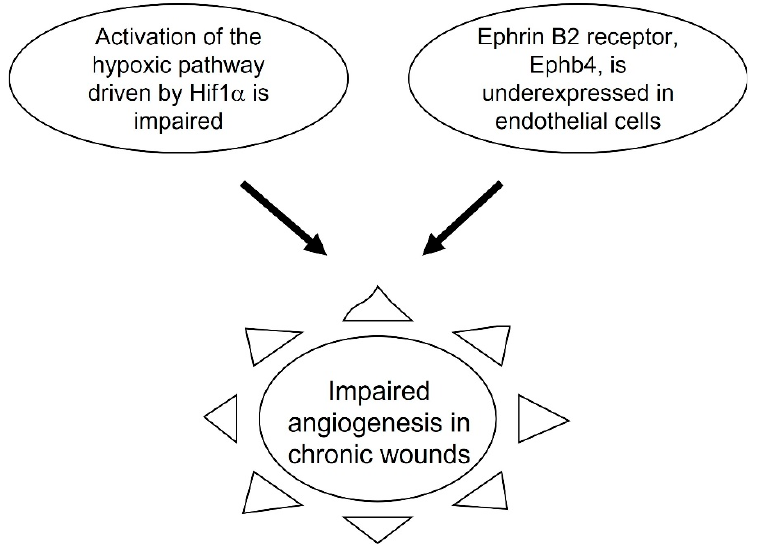
Figure 4. Impaired angiogenesis during progression to chronicity. Angiogenesis is compromised in chronic wounds. Hypoxia signaling is required for angiogenesis to occurs. However, hypoxia signaling via Hif1a in diabetic patients is impaired, and this problem becomes more aggravated during chronic wound development. Expression of Ephrin B2 in endothelial cells is also important for angiogenesis. In chronic wounds, Ephb4, the receptor for Ephrin B2, is under-expressed, resulting in impaired angiogenesis.